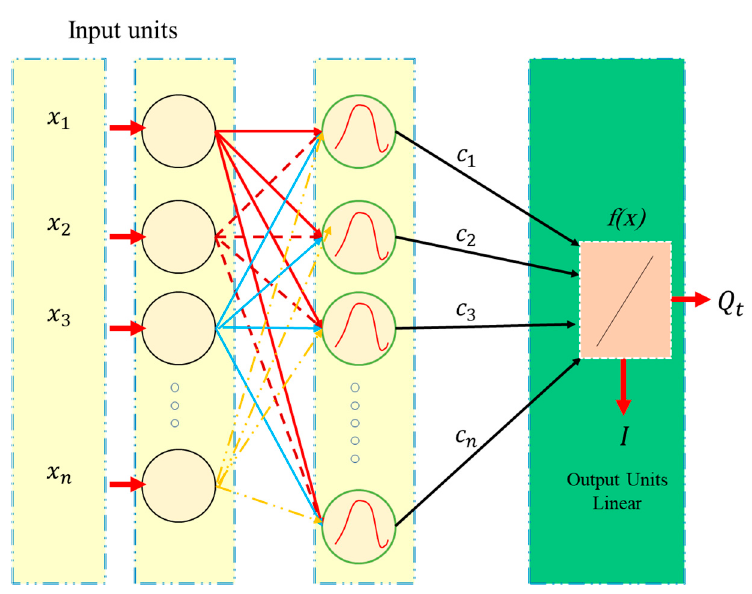
Figure 6. The structure of Radial basis function.